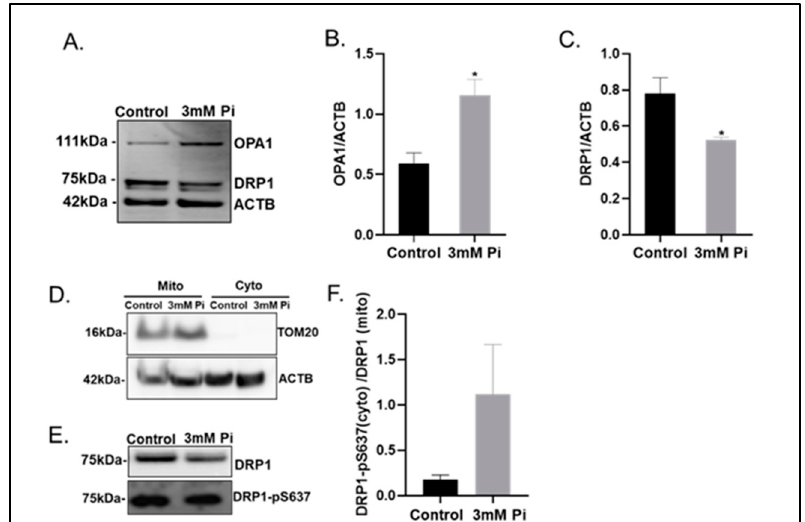
Figure 3. Calcified VSMCs show modulated Optic Atrophy Protein 1 (OPA1) and Dynamin-related protein 1 (DRP1) protein expression ( A ) Representative immunoblotting of whole cell lysates and associated quantification of ( B ) OPA1 and ( C ) DRP1 expression compared with ACTB ( β -actin). ( D ) Representative immunoblotting of mitochondrial and cytoplasmic fraction with TOM20 and ACTB ( β -actin). ( E ) Representative immunoblotting of mitochondrial expression of DRP1 and cytoplasmic expression of DRP1– pS637 associated quantification of ( F ) ratio of cytoplasmic DRP1- pS637 / mitochondrial DRP1. Data shown as mean +/ − S.E.M (n = 3) * p < 0.05 compared to control.